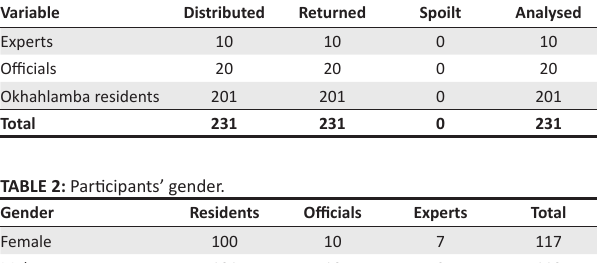
TABLE 1: Sampling and distribution of questionnaires. Variable